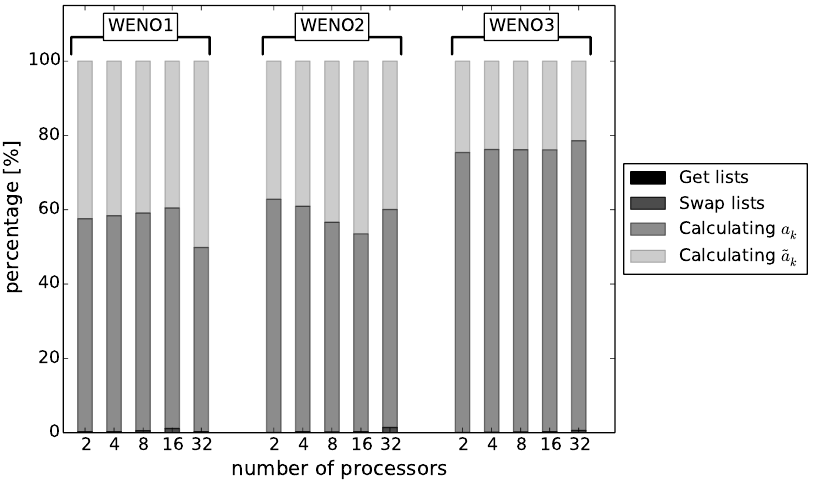
Figure 25. Percentage of single sub-steps of a WENO reconstruction. Explanation for the legend: Get lists—receive necessary lists from WENOBase, Swap lists—interprocessor communication and transmission of data of halo cells, Calculating a k —matrix vector multiplication for obtaining coefficients of sub-stencils, Calculating ˜ a k —weighting a k and summing